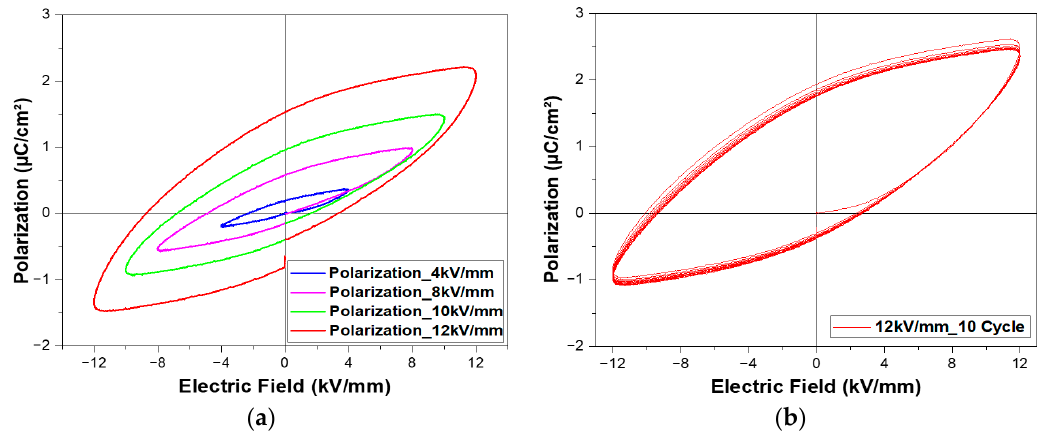
Figure 3. P–E hysteresis loops for 0 ‐ 3 PZT–PVB composite: ( a ) 4 kV/mm, 8 kV/mm, 10 kV/mm, and 12 kV/mm for 1 cycle; ( b ) 12 kV/mm for a continuous 10 cycles.